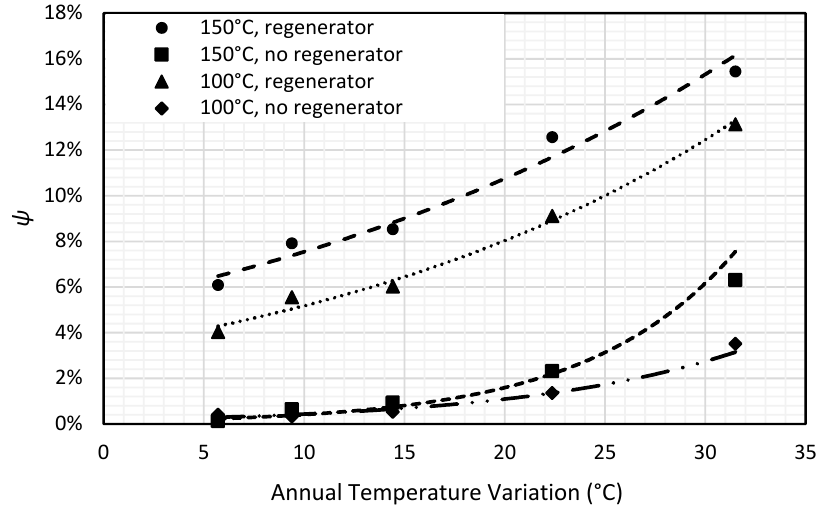
Figure 8. Variation in ψ for five case studies for annual temperature variation. From left to right, Mumbai, Ushuaia, Glasgow, Phoenix, Beijing.